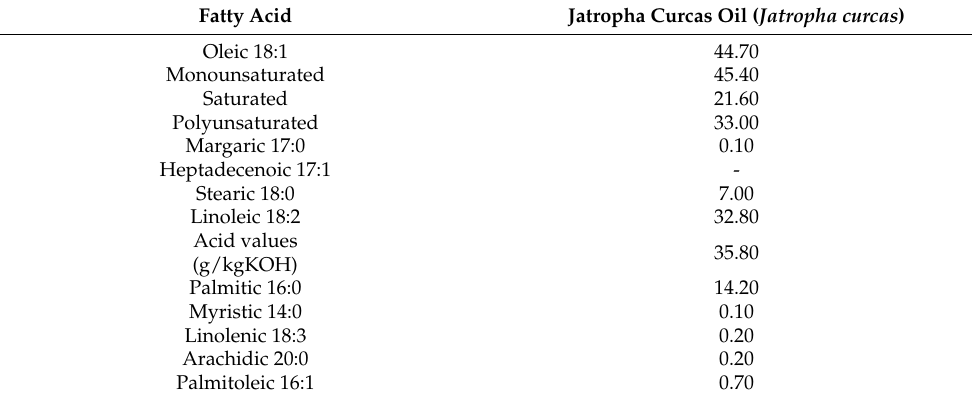
Table 12. Mono-unsaturation values of non-edible Jatropha